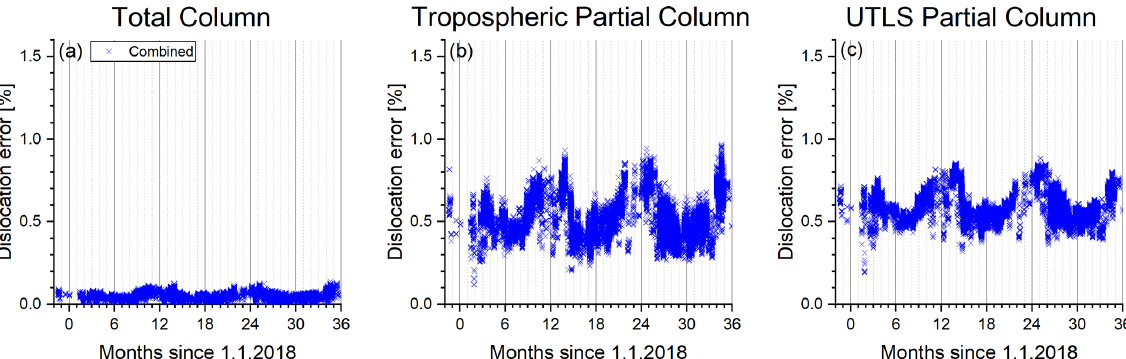
Figure 7. Time series of estimated relative dislocation error for the combined product due to temporal and spatial dislocation of the TROPOMI and IASI satellite ground pixels (example for central Europe). (a) Total column, (b) tropospheric partial column, and (c) UTLS partial